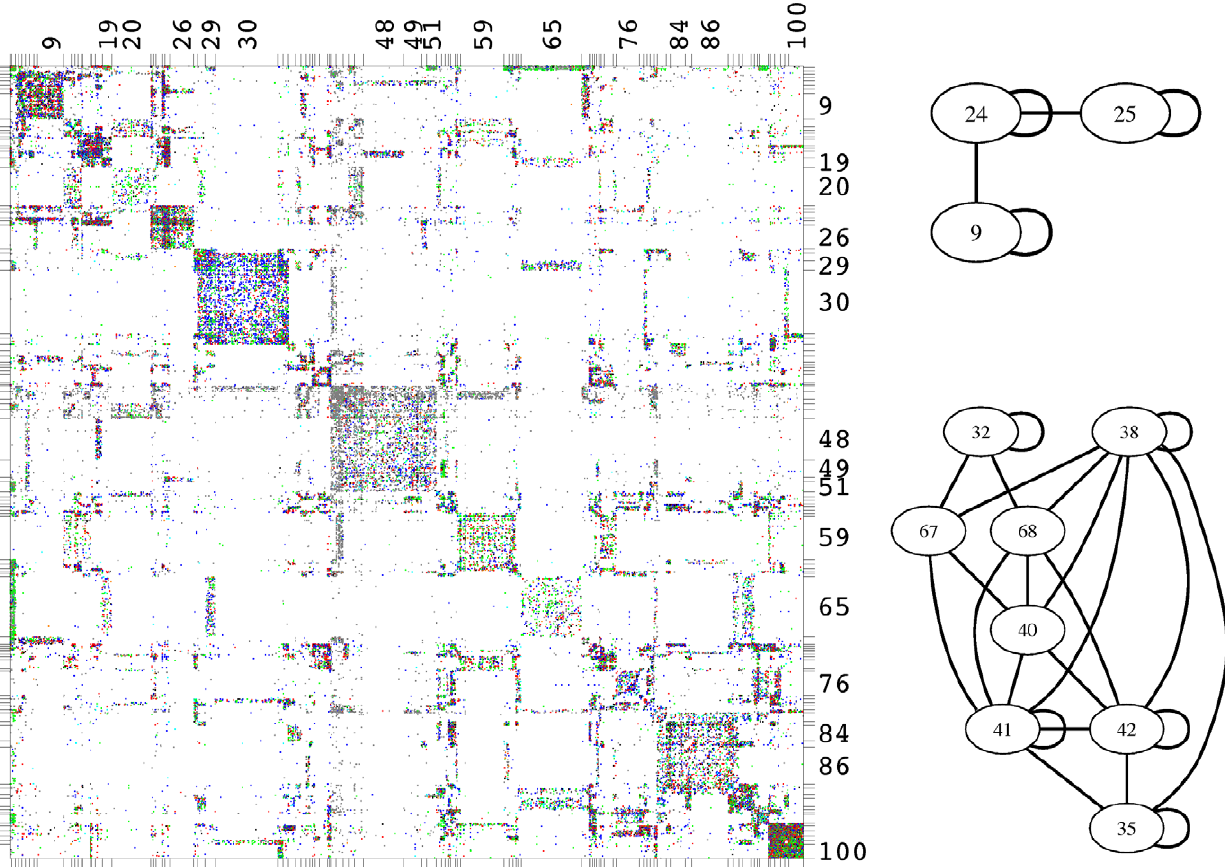
Figure 6. Block assignment in a functional role model with 100 classes. Adjacency matrix with rows and columns ordered according to assignment of proteins into classes. Color code and size of dots representing matrix entries as in figure 5. Only classes containing more than 100 proteins are labeled for better readability. Two details from the corresponding image graph exemplifying the kinds of structures found by the algorithm.